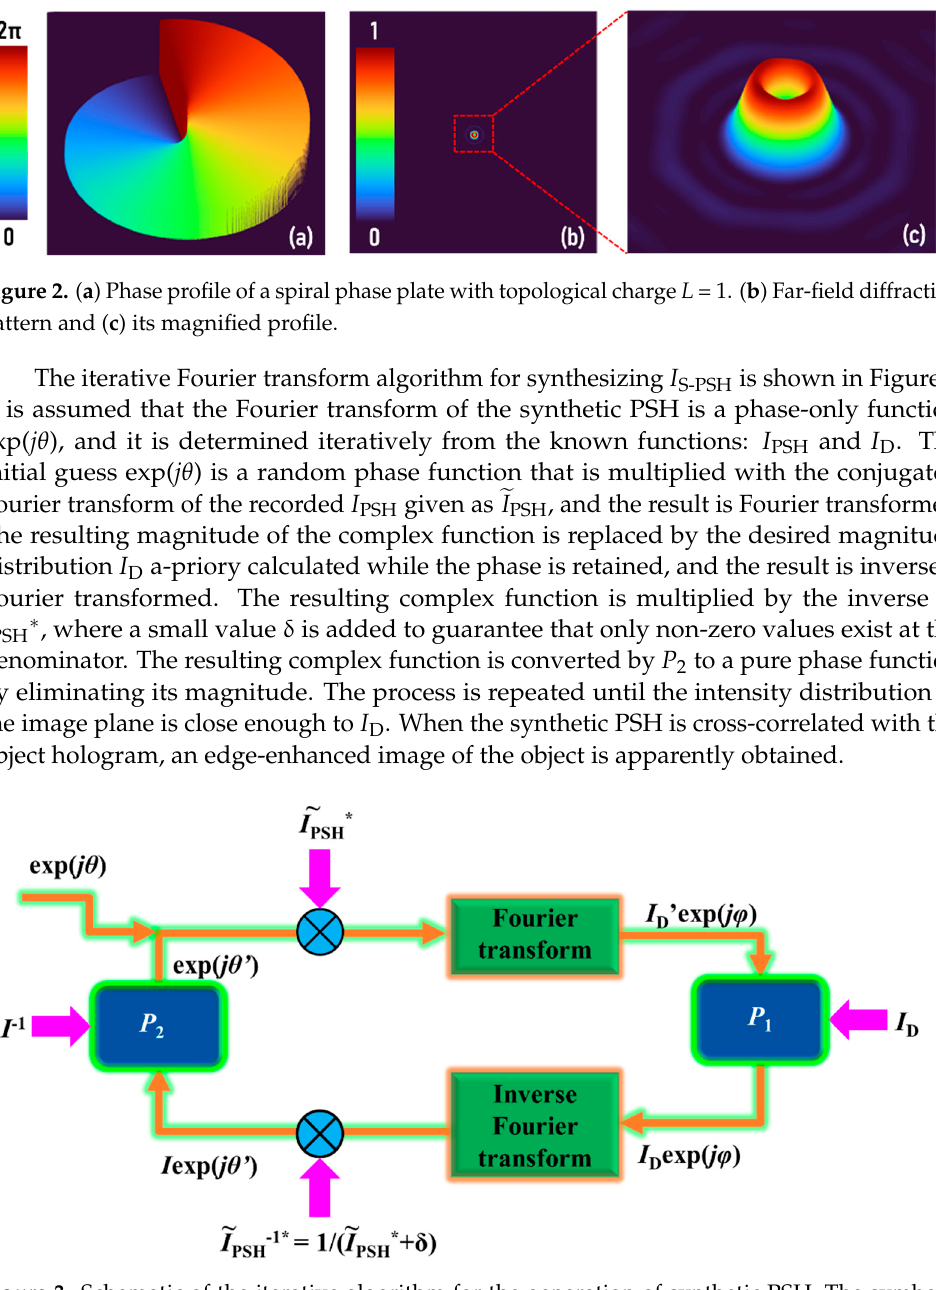
Figure 3. Schematic of the iterative algorithm for the generation of synthetic PSH. The symbol ~ above I PSH represents a Fourier transform operation, ⊗ represents a multiplication operation, and * represents complex conjugate.